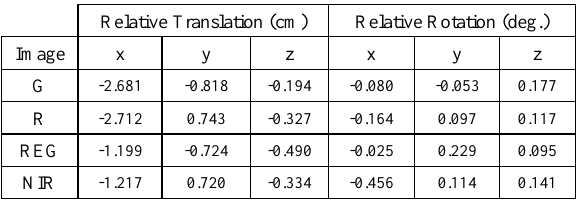
Table 1. Results of relative orientation parameters from self- calibration bundle adjustment